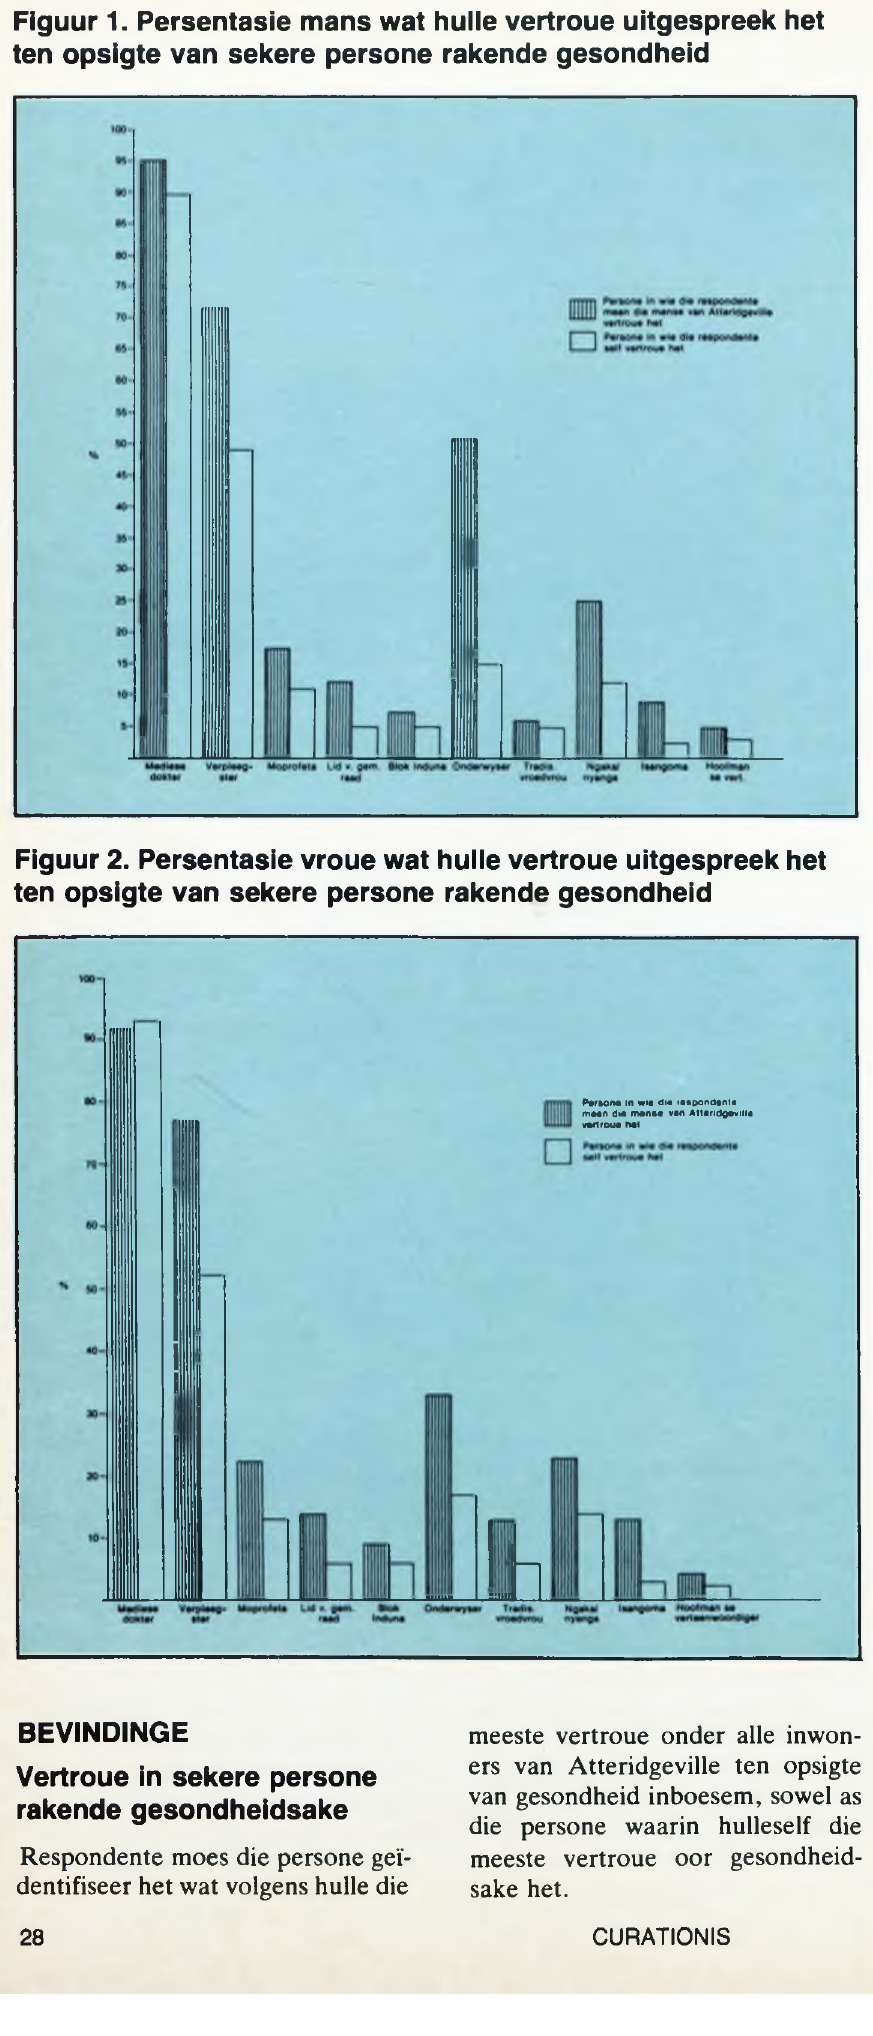
Figuur 1. Persentasie mans wat hulle vertroue uitgespreek het ten opsigte van sekere persone rakende gesondheid